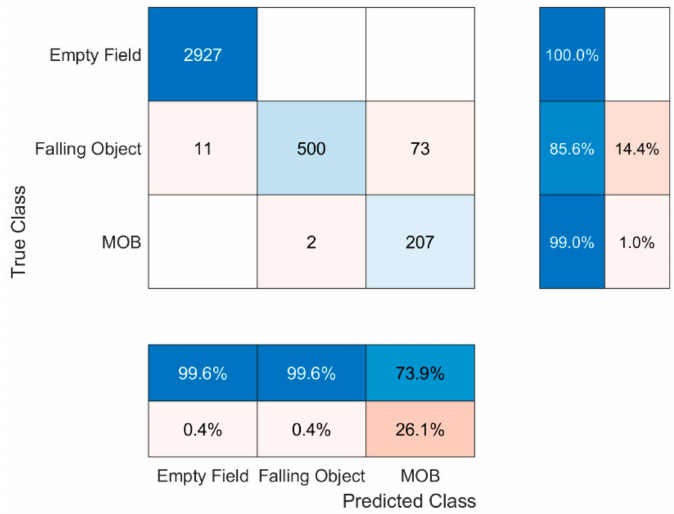
Figure 4. C1 (cid:48) s confusion matrix.